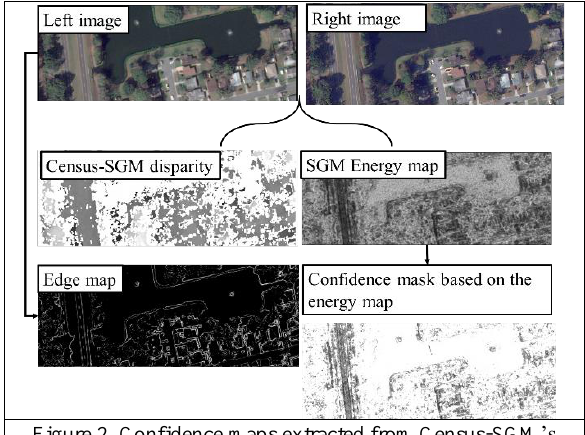
Figure 2. Confidence maps extracted from Census-SGM’s energy map and the edge map from left